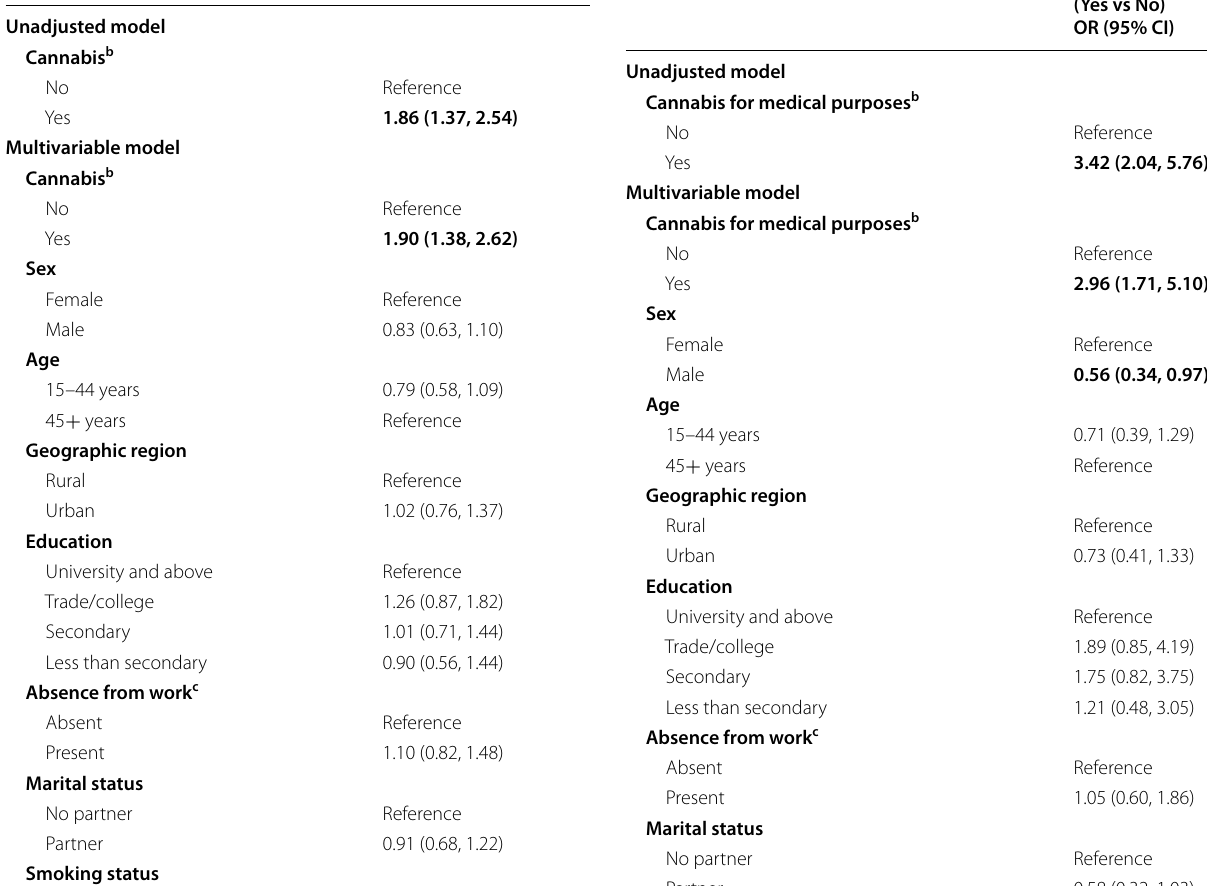
Table 4 Unadjusted and adjusted logistic regression models evaluating the association between cannabis use for medical purposes and codeine use among the Canadian Population, Canadian Tobacco, Alcohol and Drugs Survey (2017)